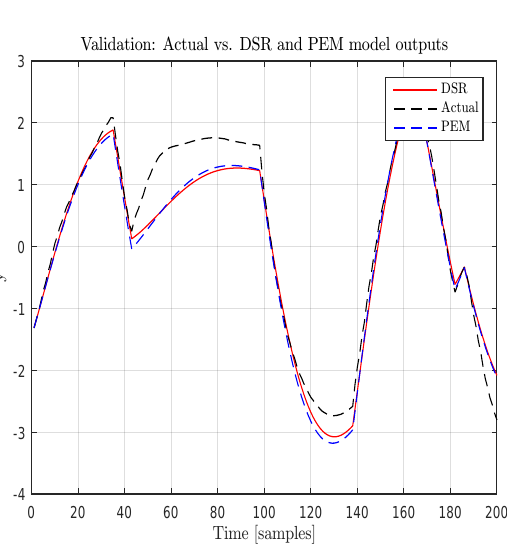
Figure 9: Example 4.3. The figure shows the compar- ison of the simulated output, y d , from the k DSR and PEM model, with the actual out- put, y k , from the validation set. The cor- responding mean square errors are given in Table 3.